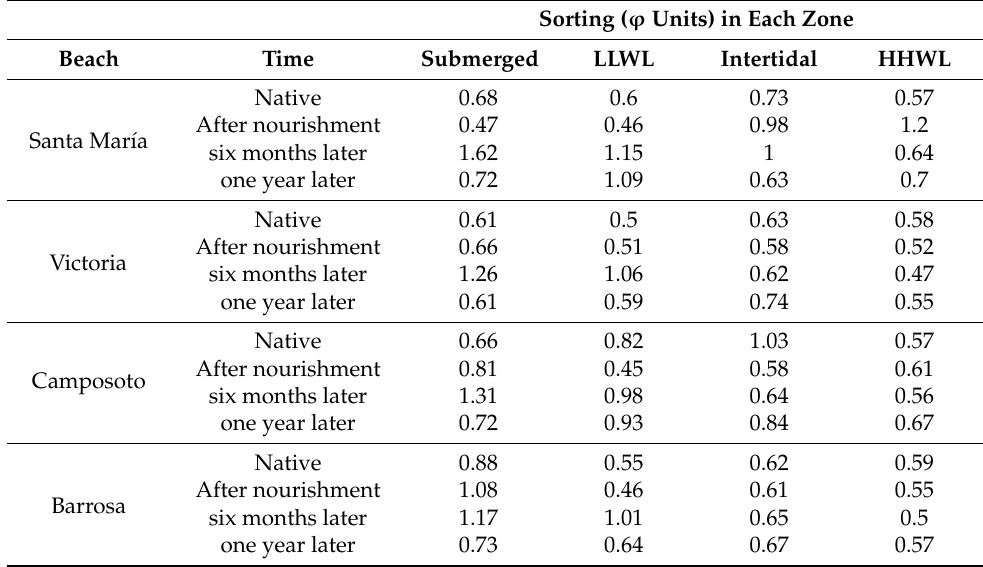
Table 4. Sorting values for every beach and surveying campaign.